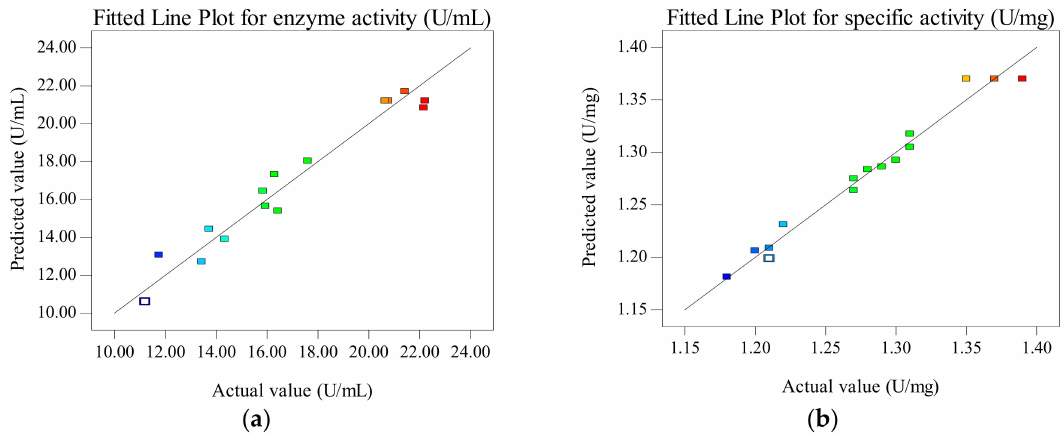
Figure 3. Fitted line plot showing the closeness between predicted values and actual values for enzyme activity ( a ) and specific activity ( b ) of CEP from L. plantarum